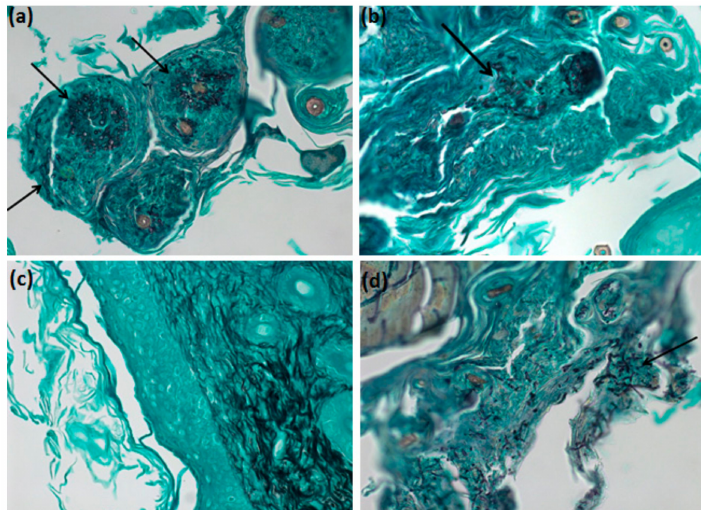
Figure 12. Grocott–Gomori microscopy of the skins of the euthanized animals with three days of treatment. ( a ) The skin of an animal infected with M. canis and without treatment. ( b ) The skin of an animal treated with 4-NC nanoparticles. ( c ) The skin of an animal treated with terbinafine. ( d ) The skin of an animal treated with empty